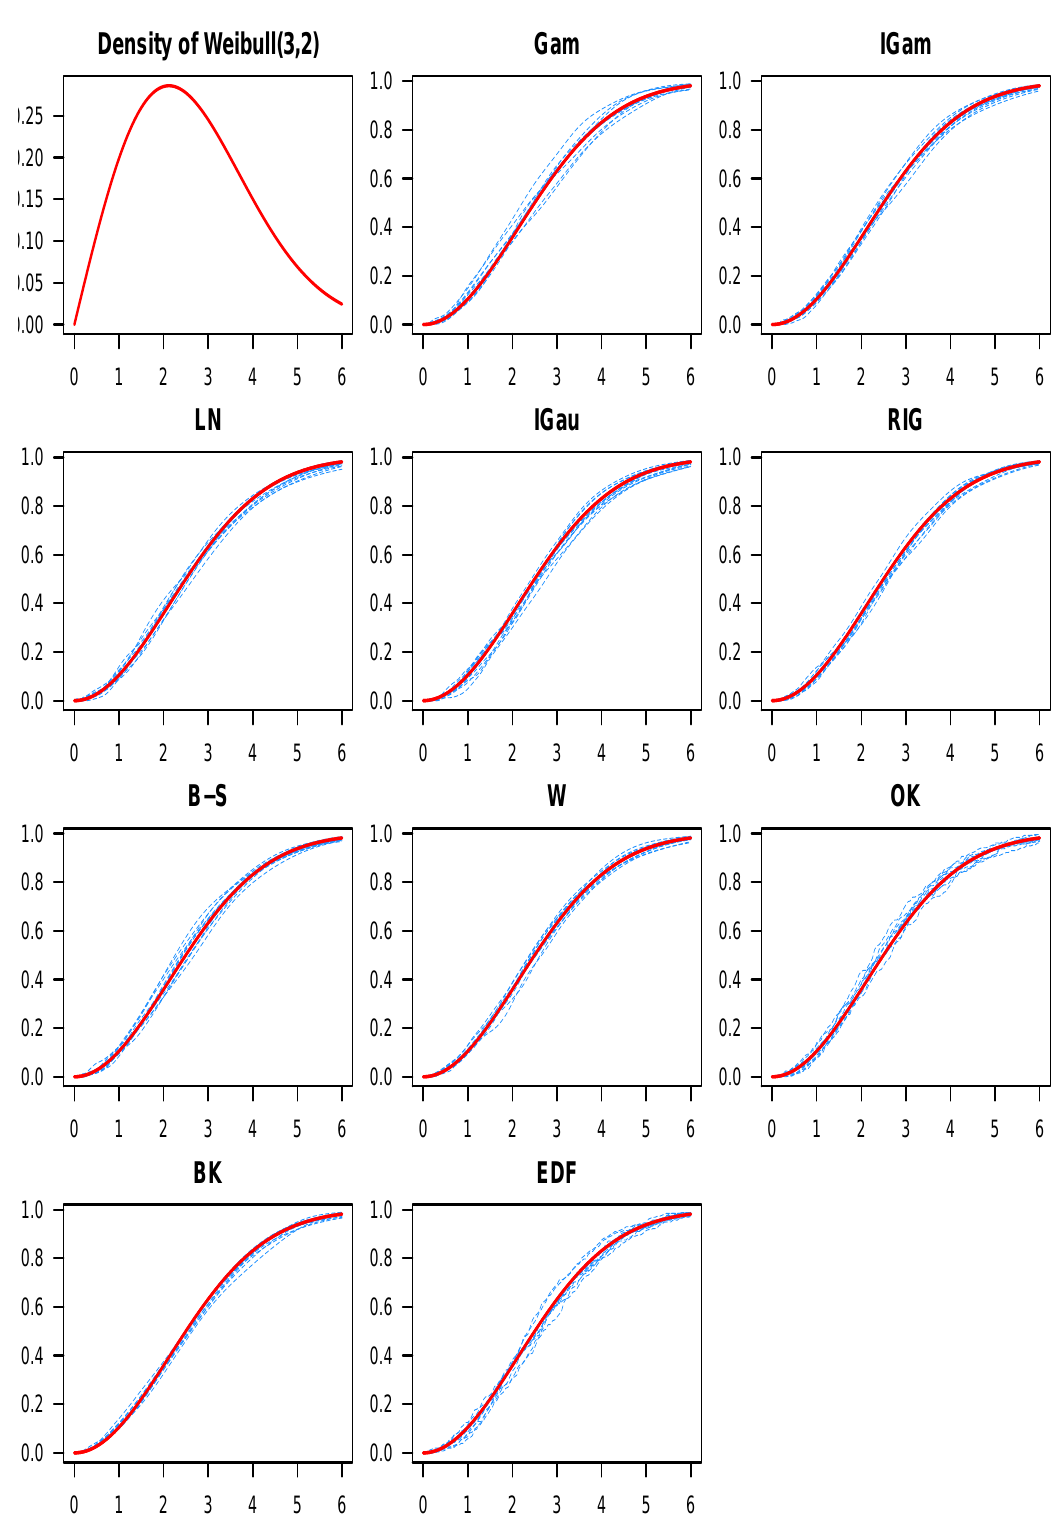
Figure 9. The Weibull ( 3,2 ) density function appears on the top-left, and the target c.d.f. is depicted in red everywhere else. Each plot has ten estimates in blue for the Weibull ( 3,2 ) c.d.f. using one of the ten estimators (the name of the corresponding kernel is indicated above each graph) and n =